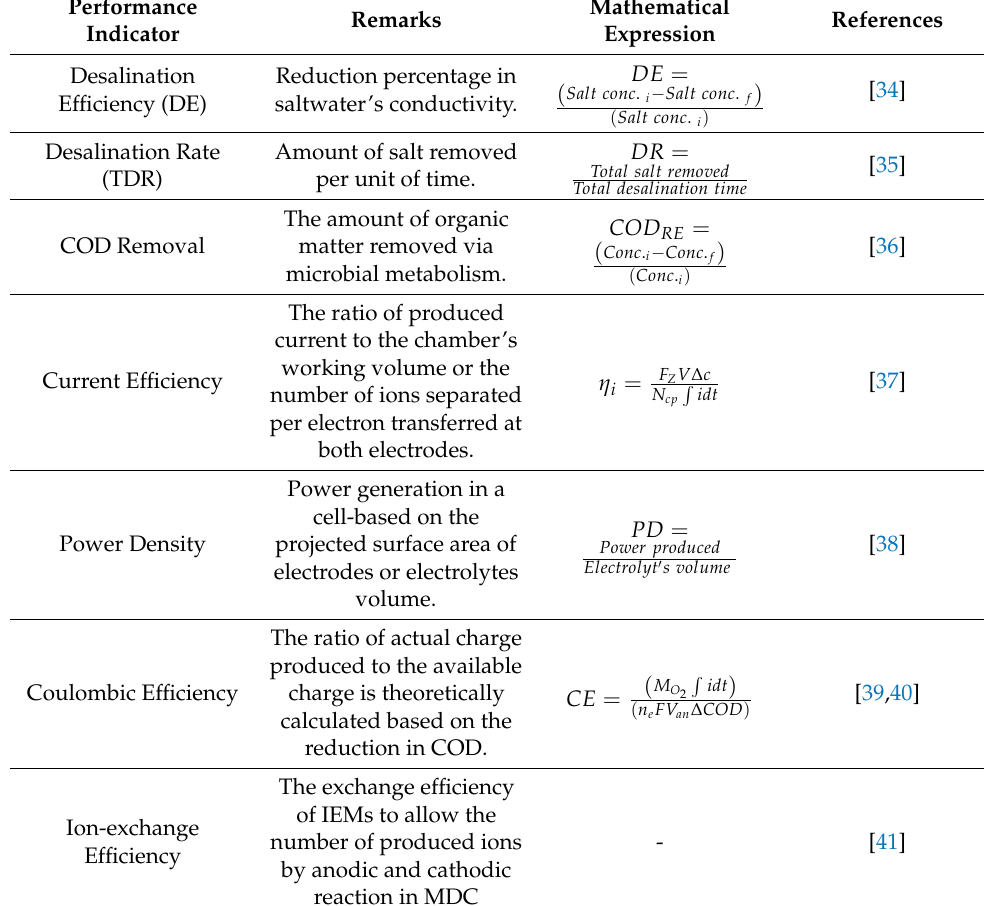
Table 1. MDC performance and efficiency indications.